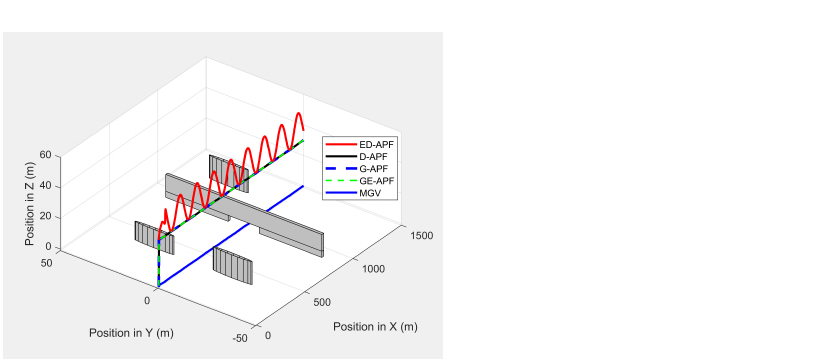
Figure 30. The UAV’s planned path in 3D when following the MGV while moving in an environment with different